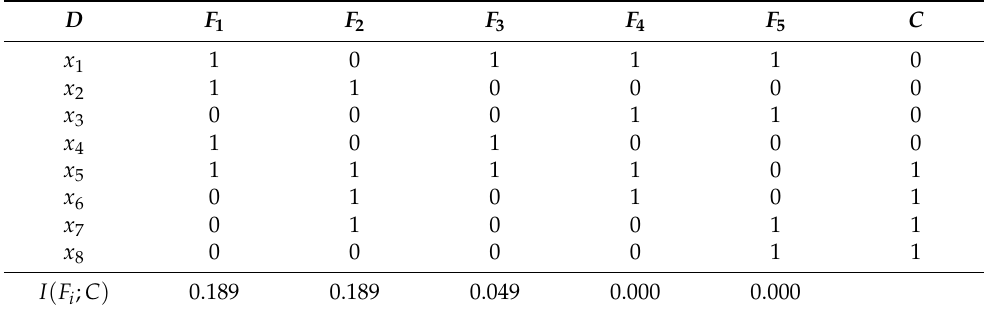
Table 1. An example dataset shown in